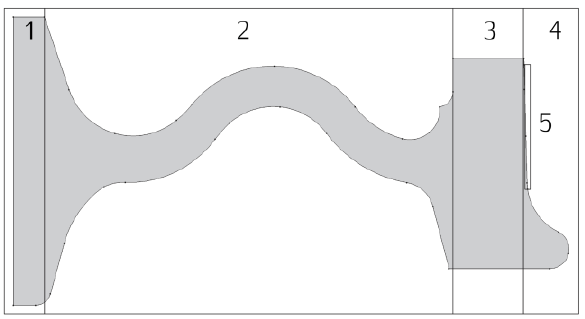
Figure 7. Areas of di ff erent convection coe ffi cient h applied in braking simulations [34].